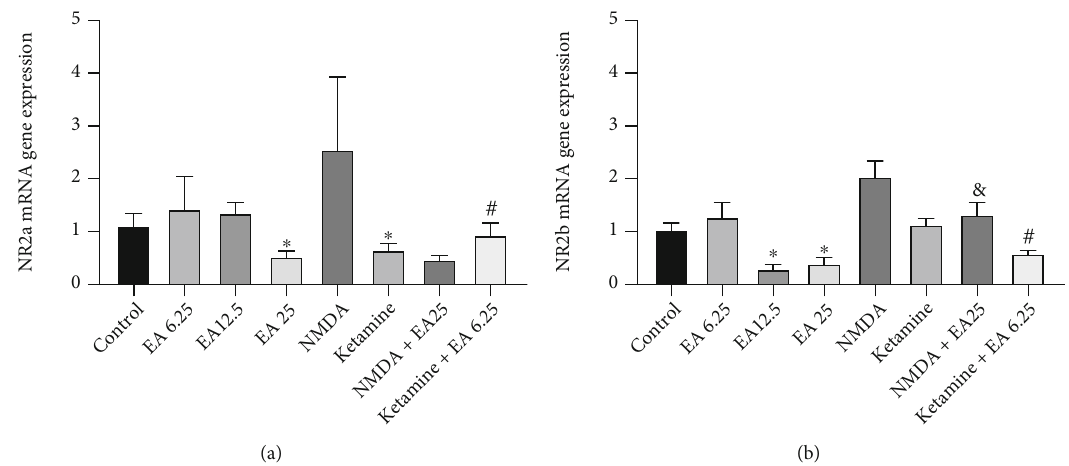
Figure 2: Expression of NMDA receptor genes in the prefrontal cortex in the experimental groups: (a) Nr2a ; (b) Nr2b . Data are reported as mean ± standard deviation and statistically analyzed by one-way ANOVA and Tukey post hoc test. ∗ P < 0 : 05 in comparison with the control group (saline-treated), # P < 0 : 05 in comparison with the group that received EA at the dose of 6.25mg/kg, and & P < 0 : 05 in comparison with the group that received EA at the dose of 25 mg/kg. EA: ellagic